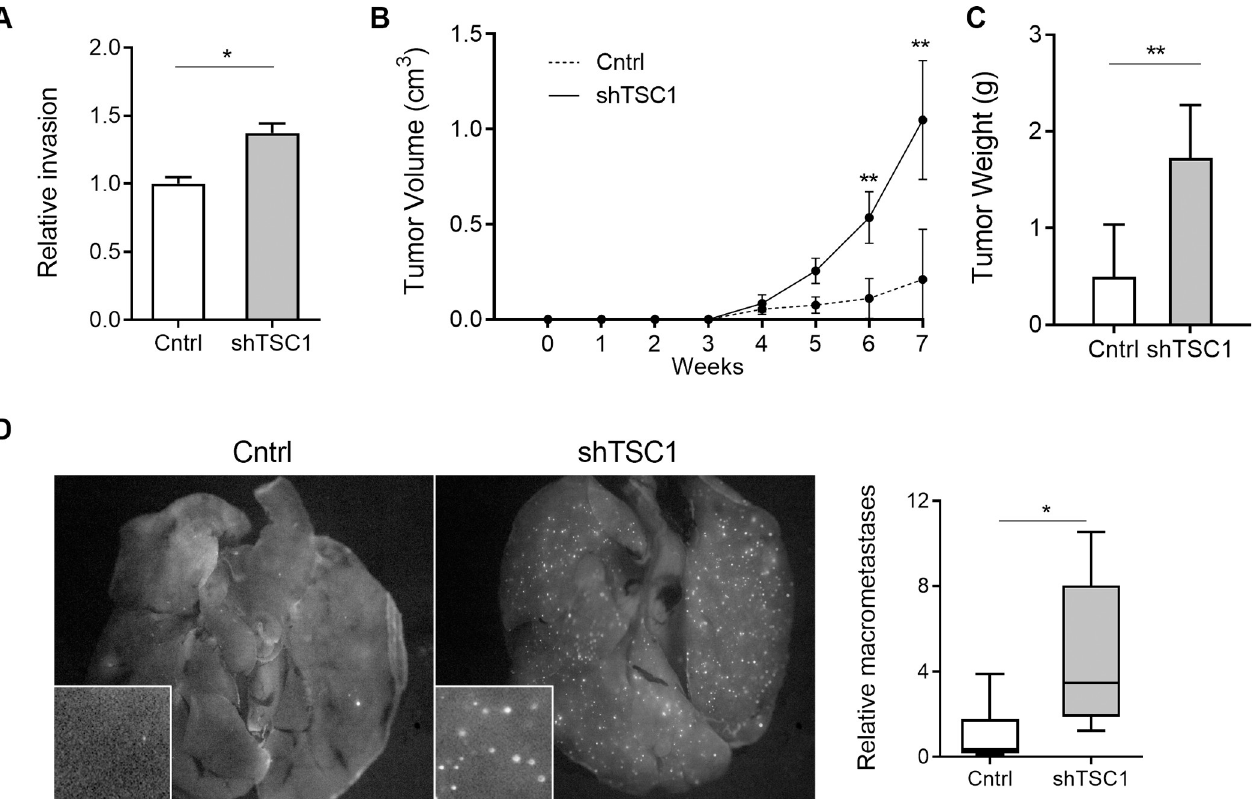
Fig 4. Independent silencing of TSC1 promotes invasion and metastasis. (A) Relative invasion of LMS cells transduced with shTSC1 or non-target shRNA control (Cntrl) in transwell assay (n = 3). Cells were counted on membrane inserts after crystal violet staining. Cell counts were normalized to the control group. (B) Primary tumor growth following subcutaneous injection of control (n = 10) and sh TSC1 (n = 10) transduced LMS1 cells in immunocompromised mice. (C) Mean weight of primary tumors at endpoint (7 weeks) for control (n = 6) and sh TSC1 (n = 8) groups. (D) Fluorescent images of GFP positive nodules in whole lungs ( left panel ). Box plot ( right ) depicts average number of GFP+ lung macrometastases in 3 randomly chosen fields ( inset ) for Ctrl (n = 10) and sh TSC1 (n = 10) xenografted tumors. Statistical analyses were performed by two-tailed students t-test; � P < 0.05, �� P < 0.005.